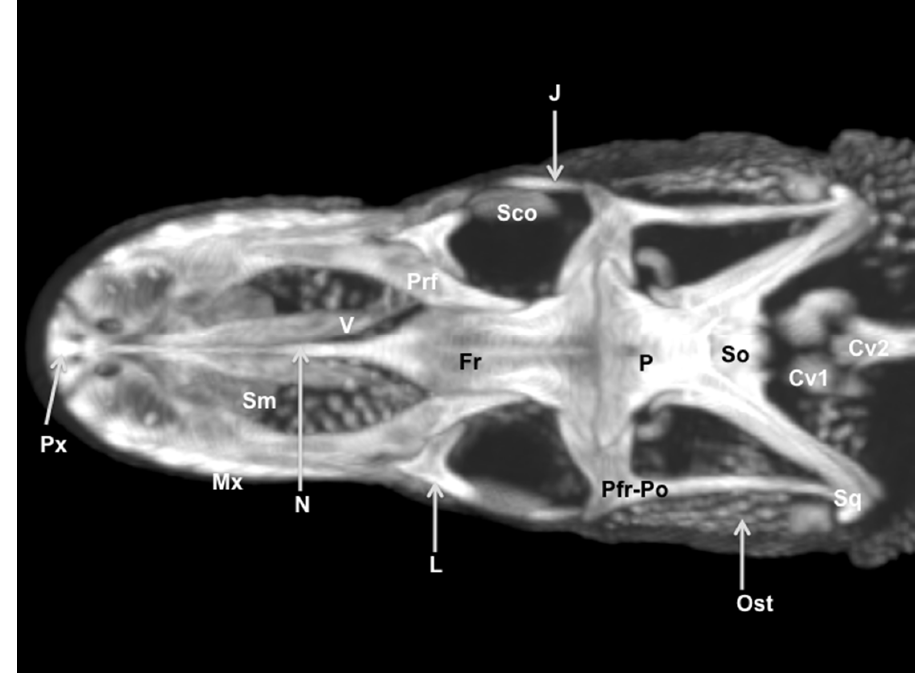
Figure 10. Dorsal MIP image of the cranium of Varanus komodoensis . Px: Premaxillary bone. Mx: Maxillary bone. Sm: Septomaxilla. V: Vomer. N: Nasal bone. Prf: Prefrontal bone. Fr: Frontal bone. L: Lacrimal bone. Sco: Scleral ossicles. J: Jugal bone. Pfr-Po: Postfrontal + postorbital. P: Parietal. So: Supraoccipital. Sq: Squamosal. Ost: Osteoderms. Cv1: First cervical vertebra. Cv2: Second cervical vertebra.